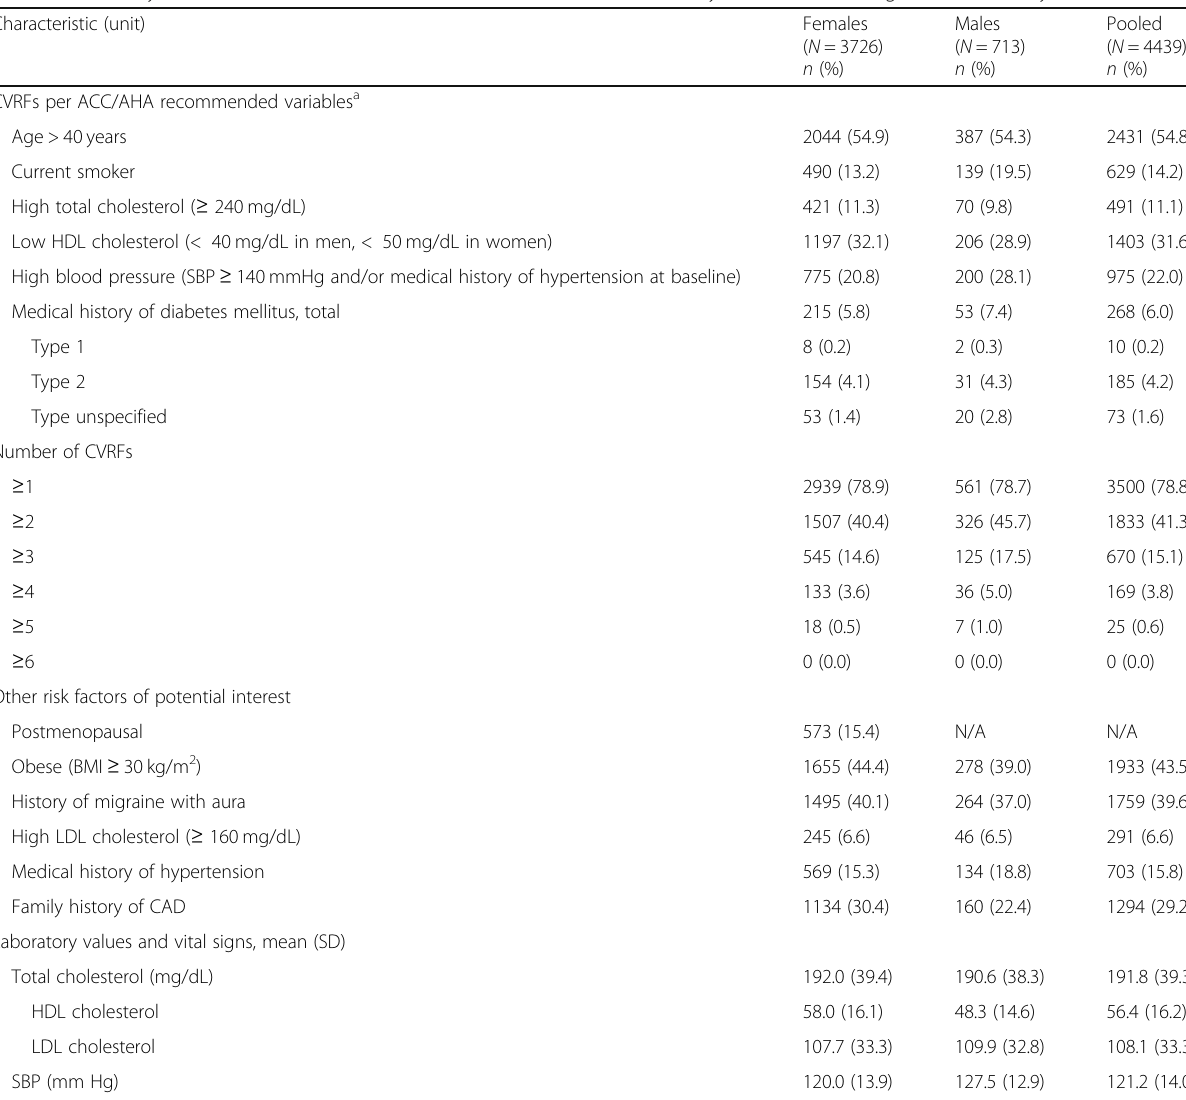
Table 1 Summary of cardiovascular risk factors, other risk factors, and laboratory values and vital signs at baseline by sex Characteristic